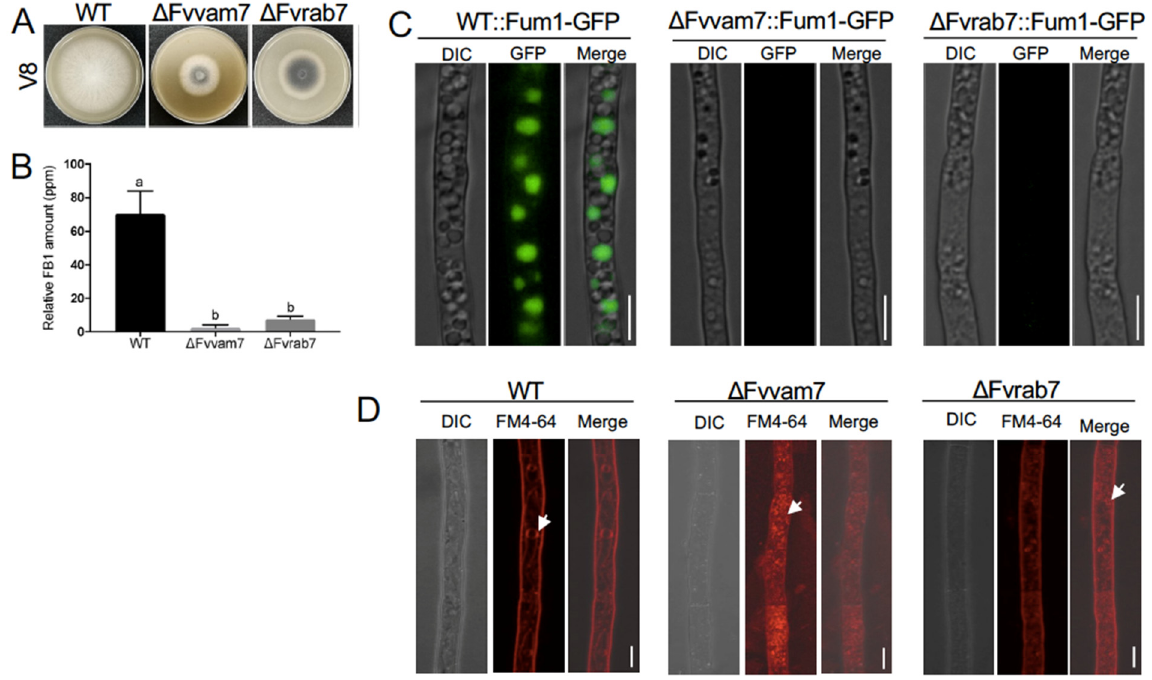
Figure 3. Co-localization of Fum1 with FvVam7 or FvRab7 proteins. FvFum1-GFP was co-localized with FvVam7-mCherry or FvRab7-mCherry in hyphae cultured in myro broth. Images were taken after 48 h constant shaking at 28 °C. Bar = 5 μ m.